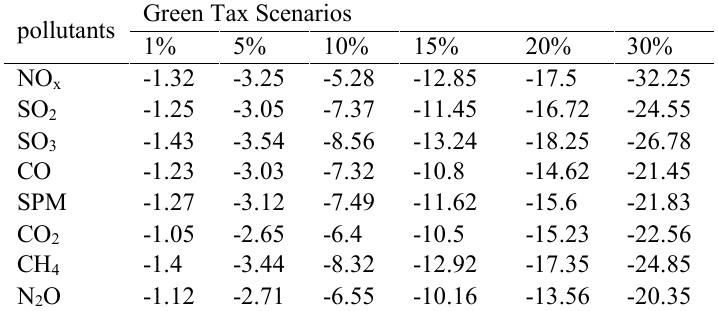
Table 1. Change in emission levels in response to different green tax